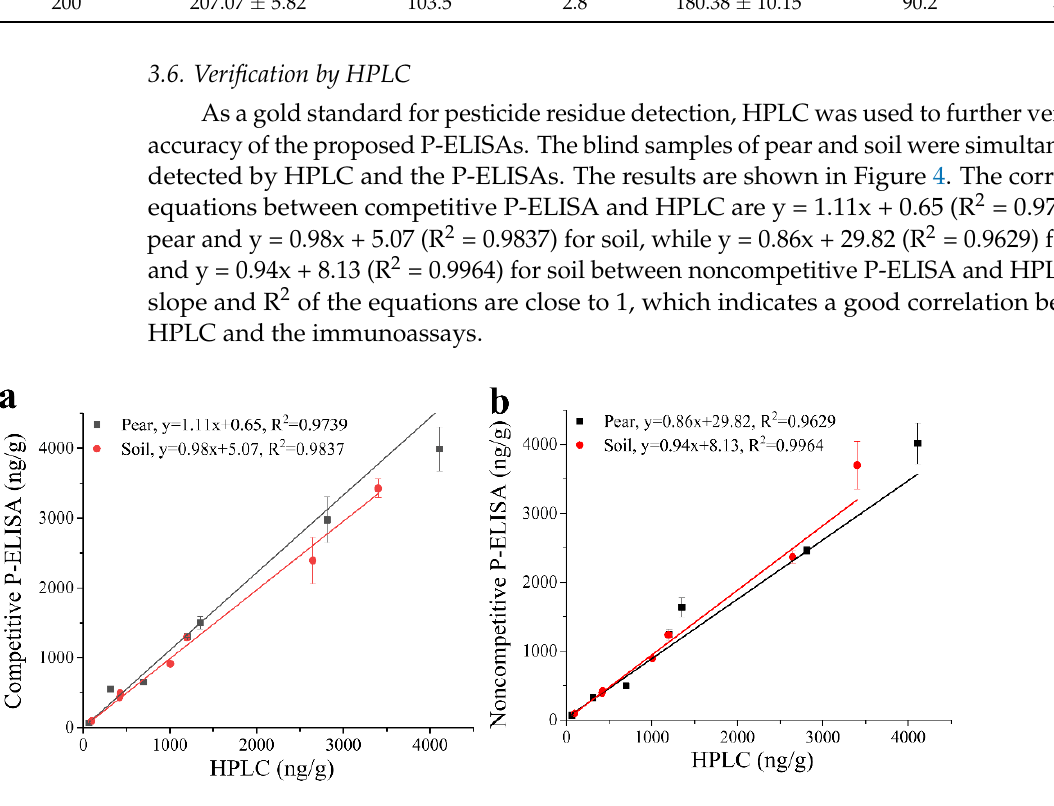
Table 3. Recoveries of spiked samples for IMI ( n = 3).